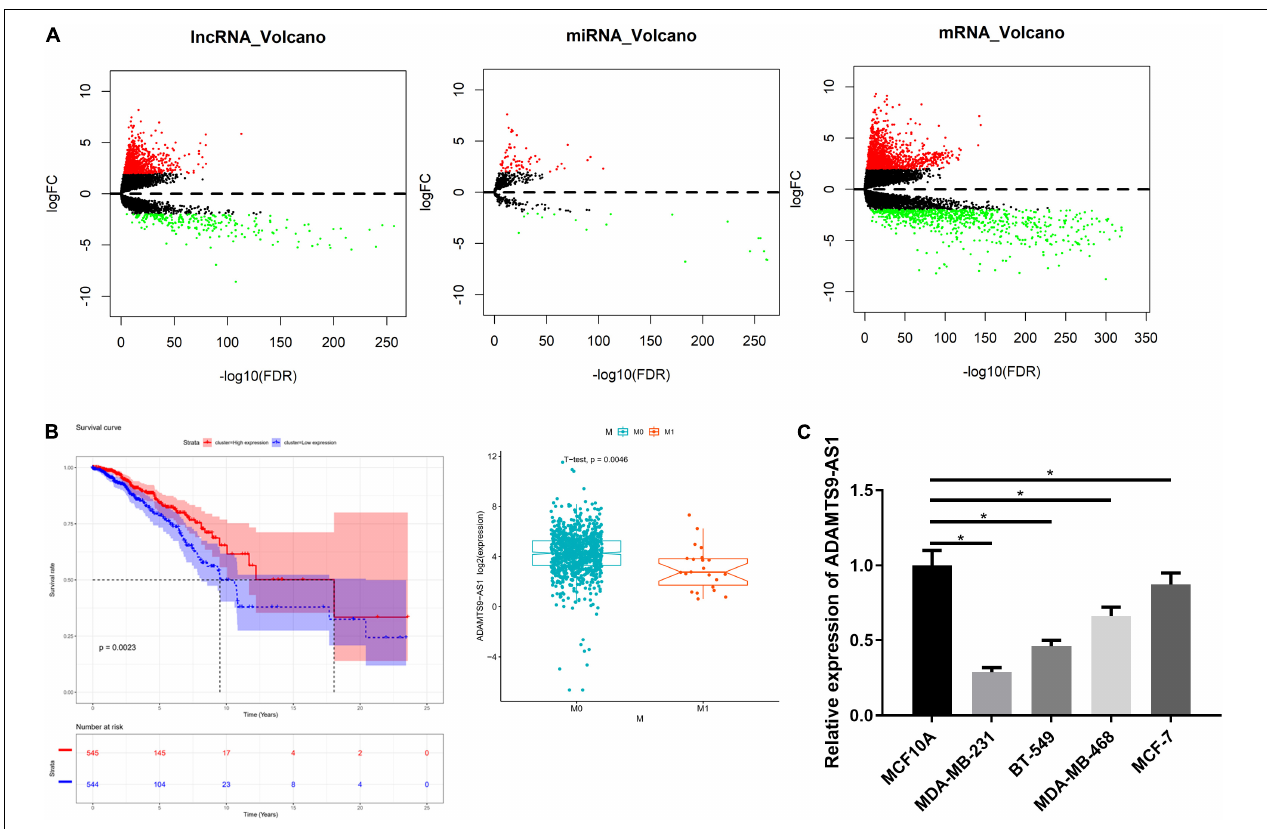
FIGURE 1 | ADAMTS9-AS1 is lowly expressed in breast cancer. (A) Volcano map of DElncRNAs, DEmiRNAs and DEmRNAs in breast cancer tumor group and normal group. (B) The survival curve of ADAMTS9-AS1 expression level on the prognosis of patients, with X -axis representing time (in years) and Y -axis representing survival. Red: high expression, blue: low expression. (C) The level of ADAMTS9-AS1 in breast cancer cells; * p <